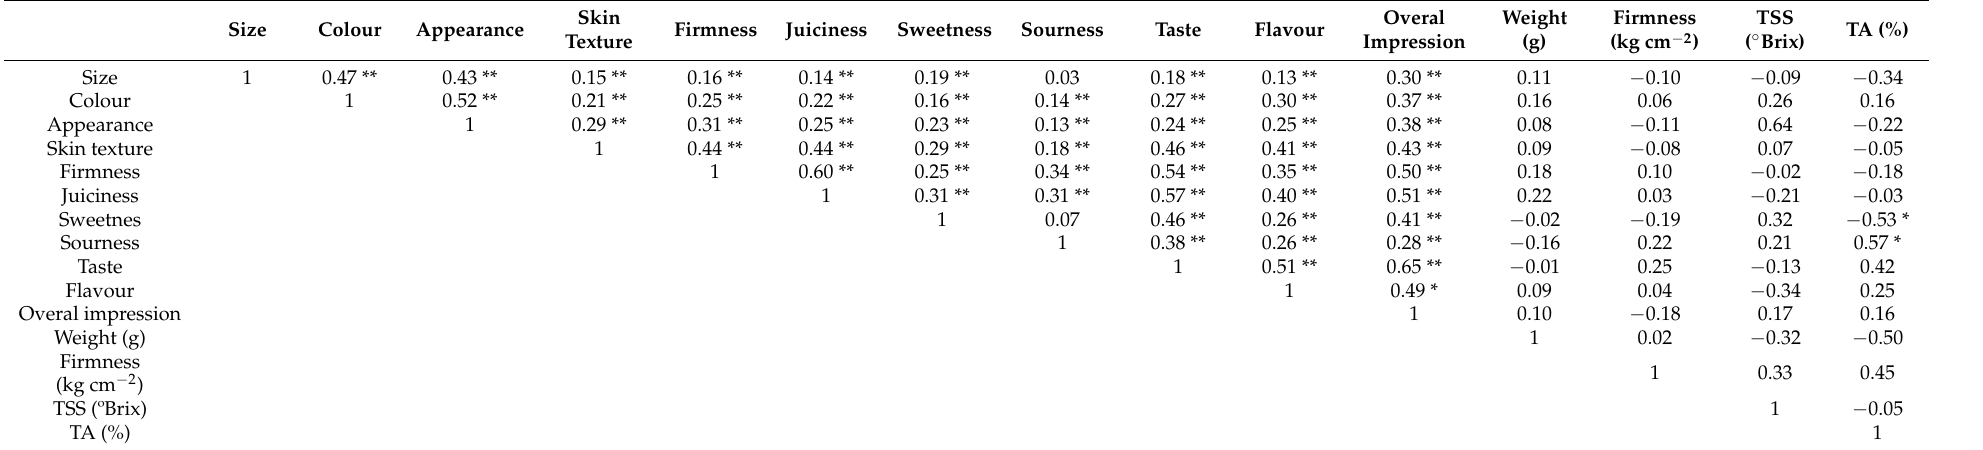
Table 5. Pearson correlation coefficients between sensory fruit attributes (appearance, size, colour, firmness, skin texture, juiciness, sweetness, sourness and flavour) and pomological fruit characteristics (weight, flesh firmness, total soluble solids and titratable